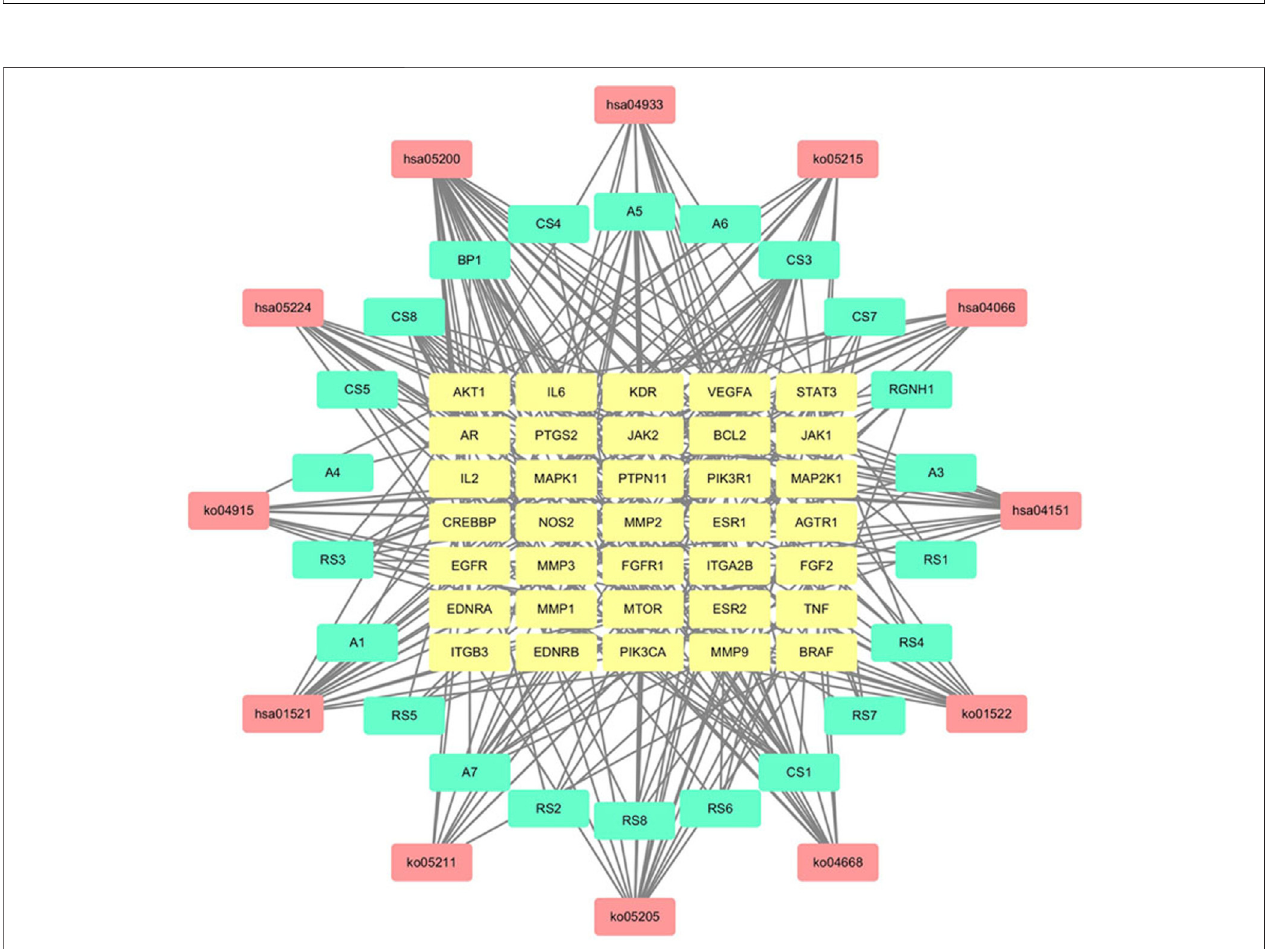
FIGURE 9 | C-T-P network for CVDs treatment of HJP (The yellow, blue and red nodes represented the active components, gene targets, and pathways, respectively.).